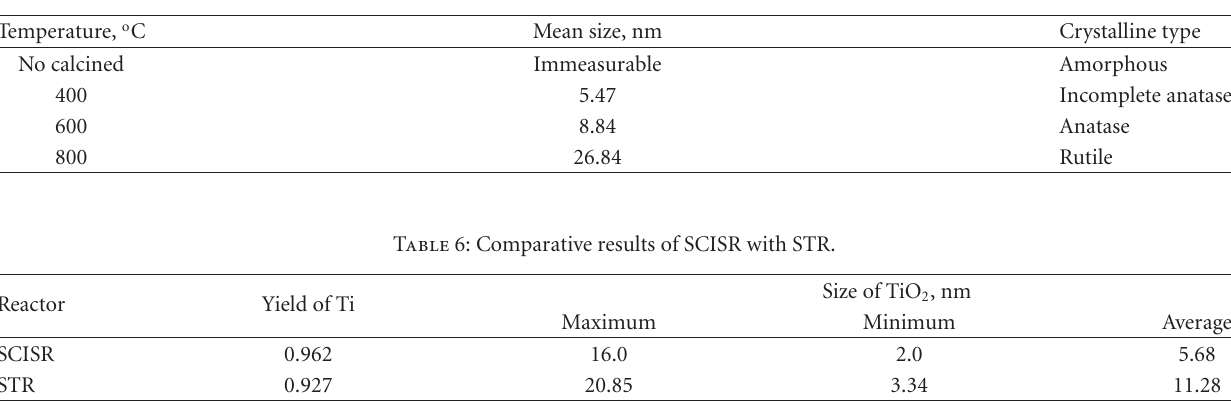
Table 5: Particle sizes and crystalline types of nano-Titania calcined at di ff erent temperatures.